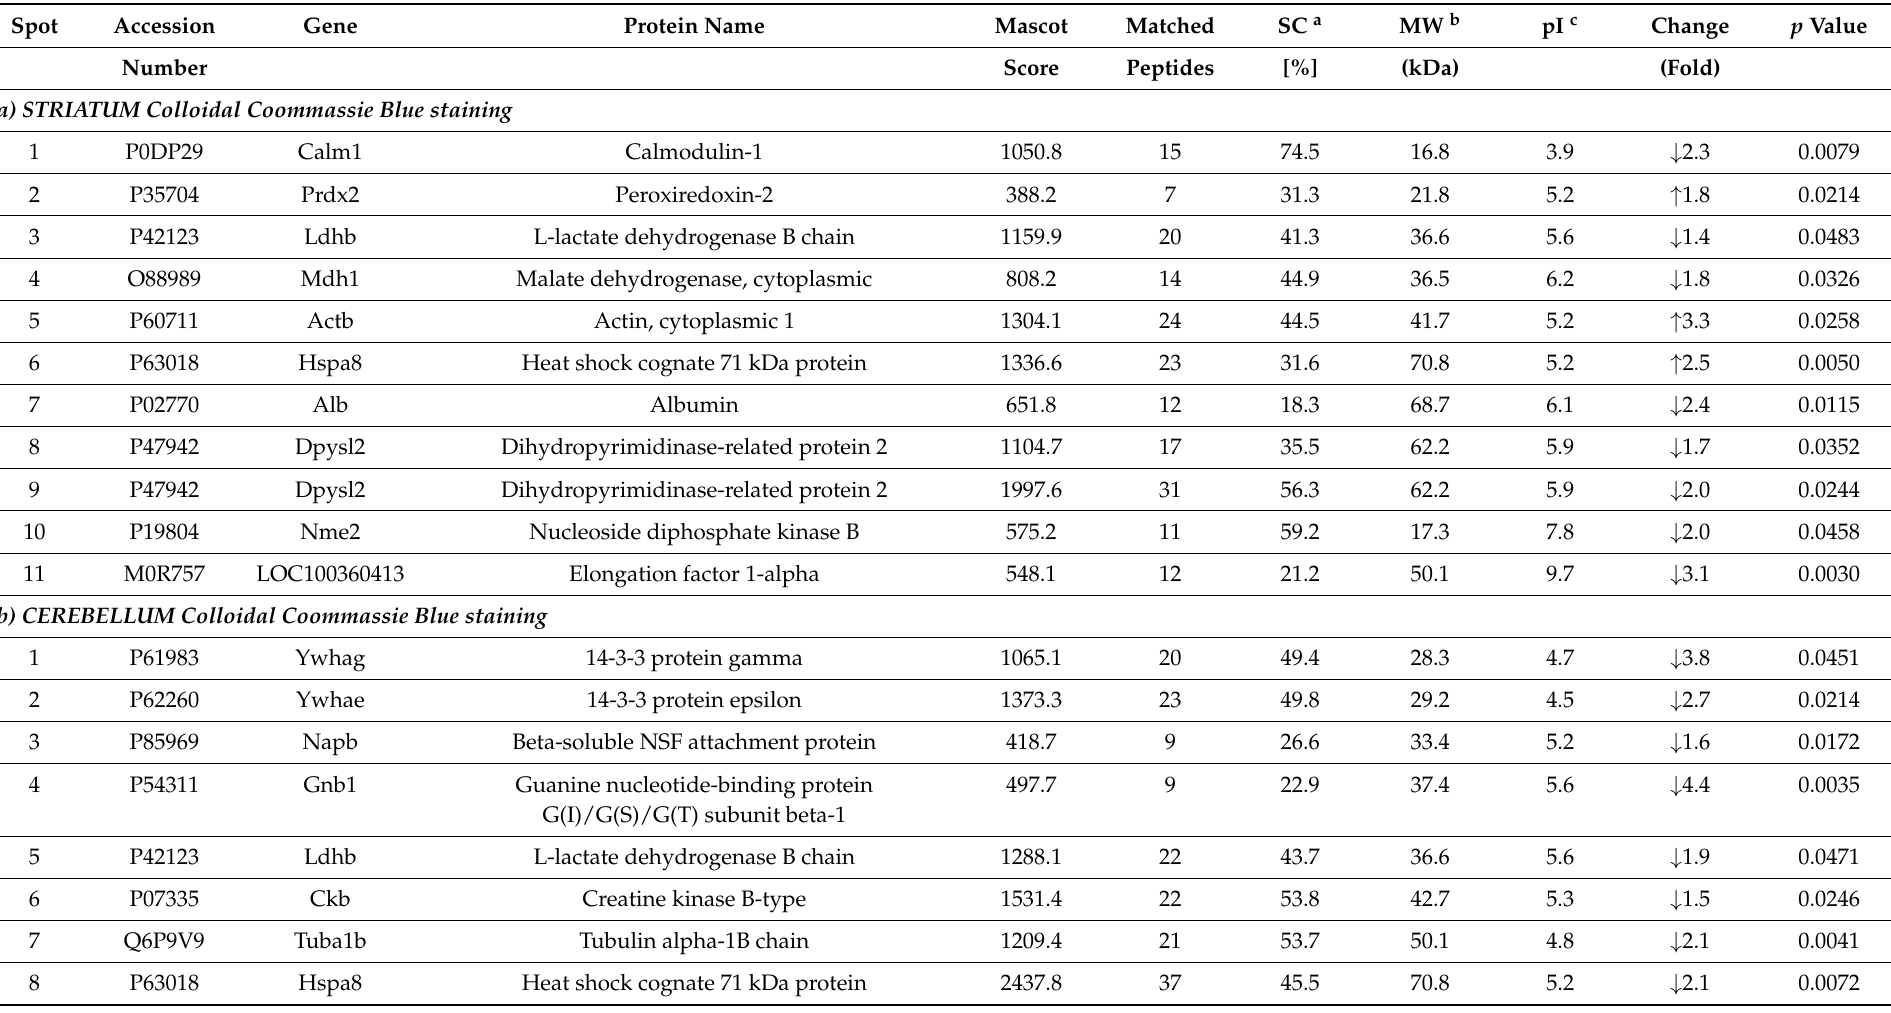
Table 5. nLC-MS/MS analysis of significantly altered protein spots identified in the rat striatum ( a ) and cerebellum ( b ) isolated from animals after 6 months of morphine